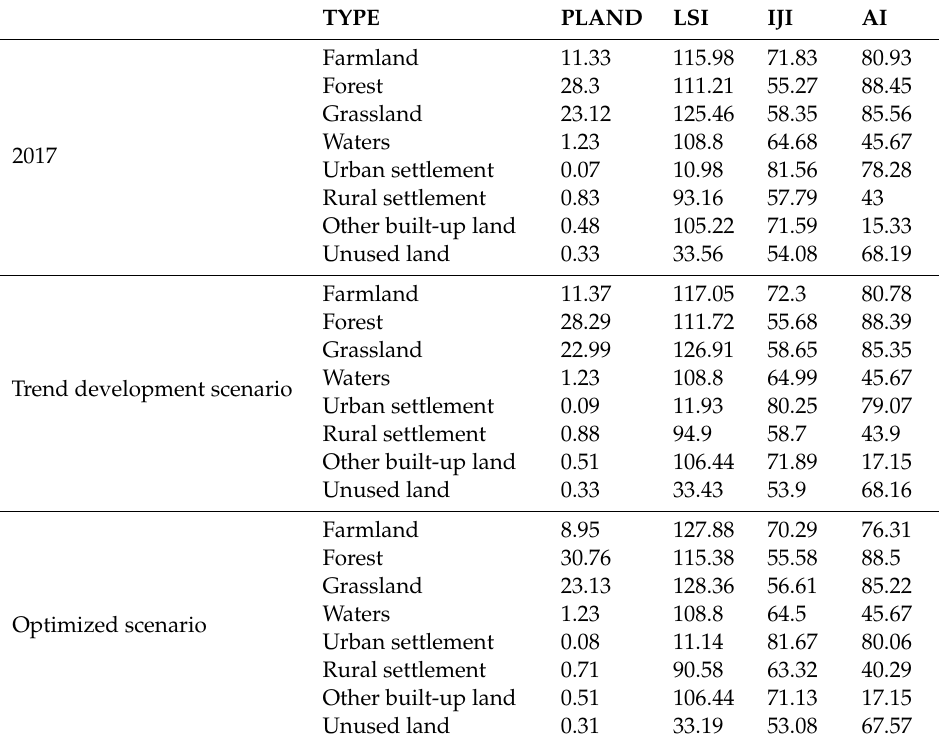
Table 6. Landscape index at type level in Puge County from 2017 to 2030 (%).